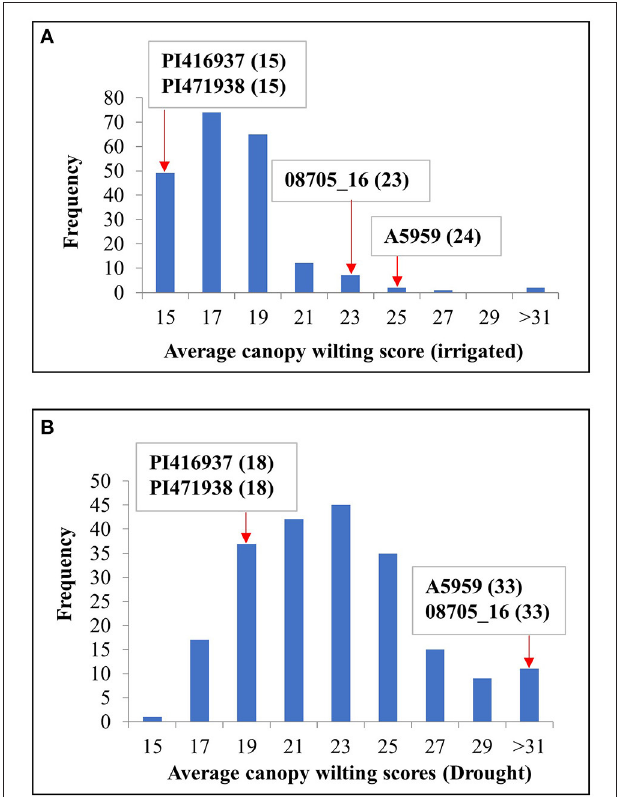
FIGURE 1 | Frequency distribution of maturity group (MG) IV genotypes for canopy wilting (CW) scores averaged across all environments for both (A) irrigated (IR) and (B) drought (DR) treatments. PI 416937 and PI 471938 were slow-wilting controls, whereas genotypes A5959 and 08705_16 were fast-wilting controls. Numbers in parentheses indicate the wilting scores for the checks.